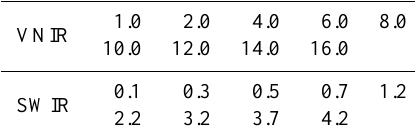
Table 2. Integration times ( ms ) used for nonlinearity measurements with the large integrating